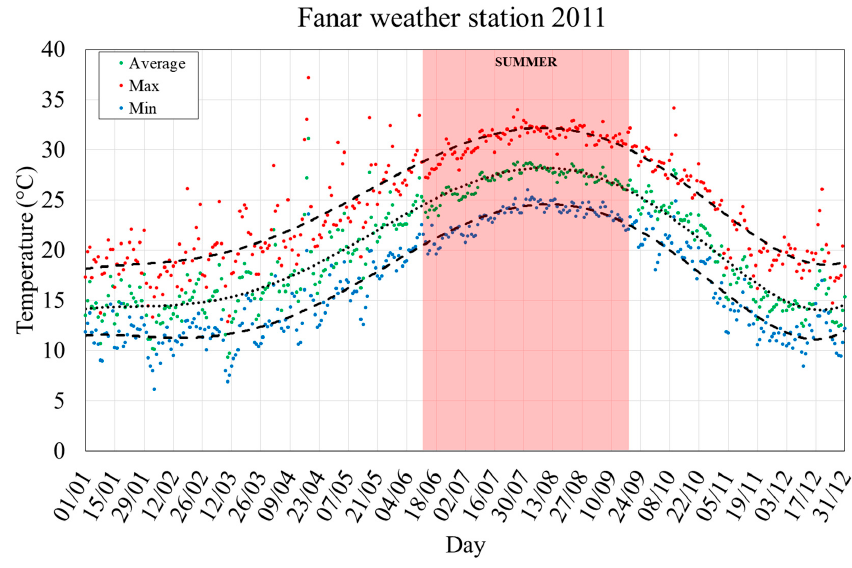
Figure 4. Minimum, maximum and average air temperature in the summer of 2011 of Fanar weather station